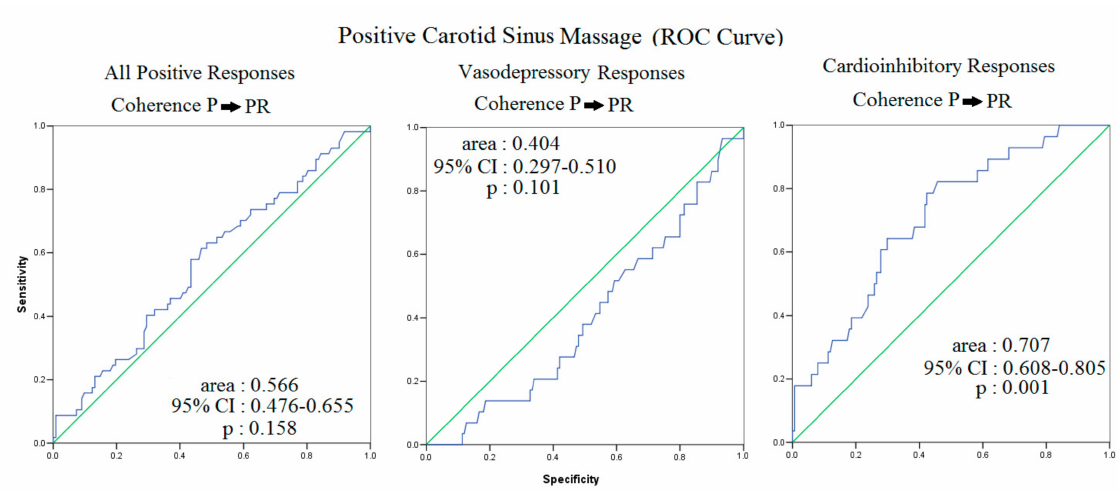
Figure 6. Receiver operating characteristic curve (ROC) analysis showing that P → PR coherence predicts an incidence of sinus hypersensitivity with cardioinhibitory